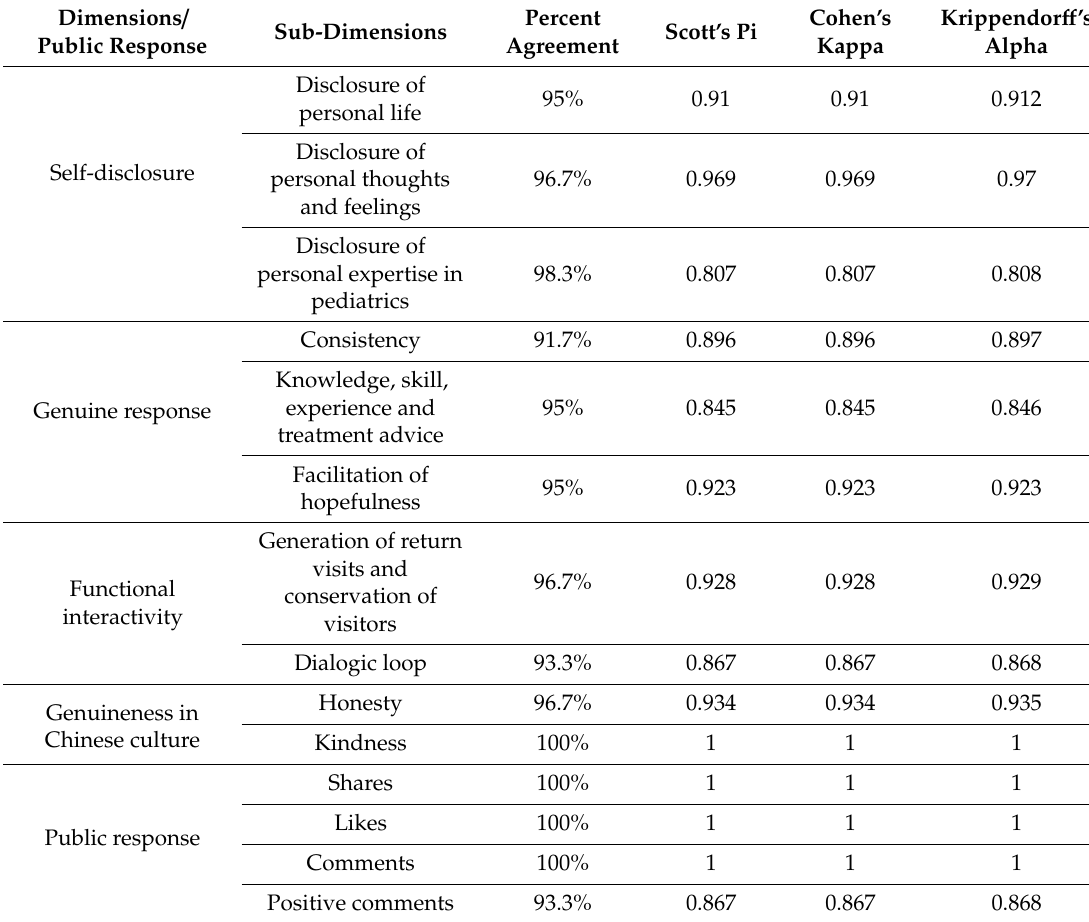
Table 3. Summary of Inter-Rater Reliability